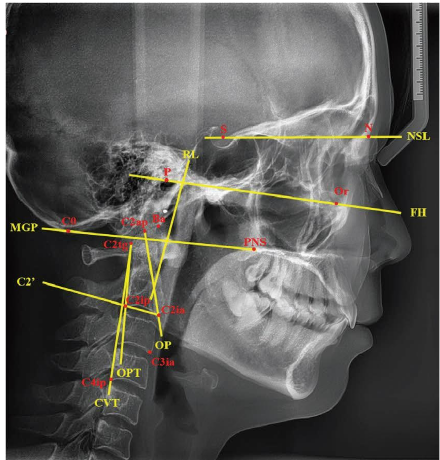
Figure 1: Cephalometric reference points and lines used in this